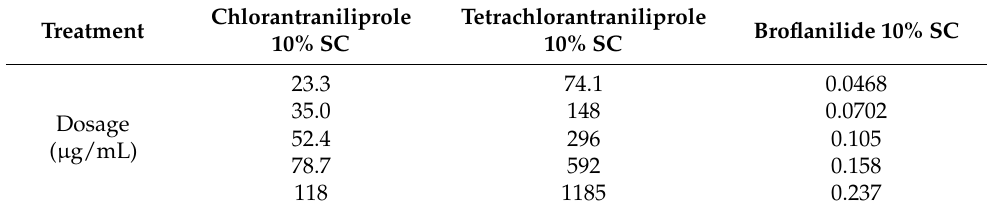
Table 1. The test solutions of three diamide insecticides.